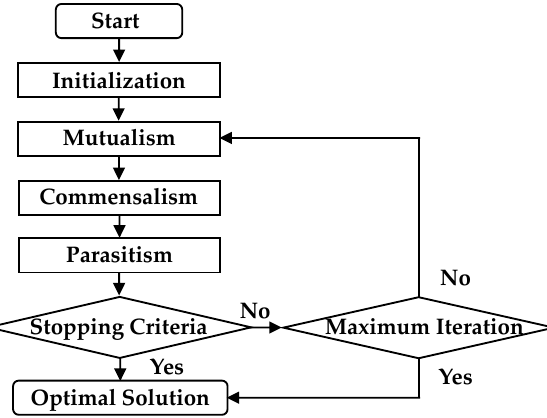
Figure 2. Flowchart of symbiotic organism search.